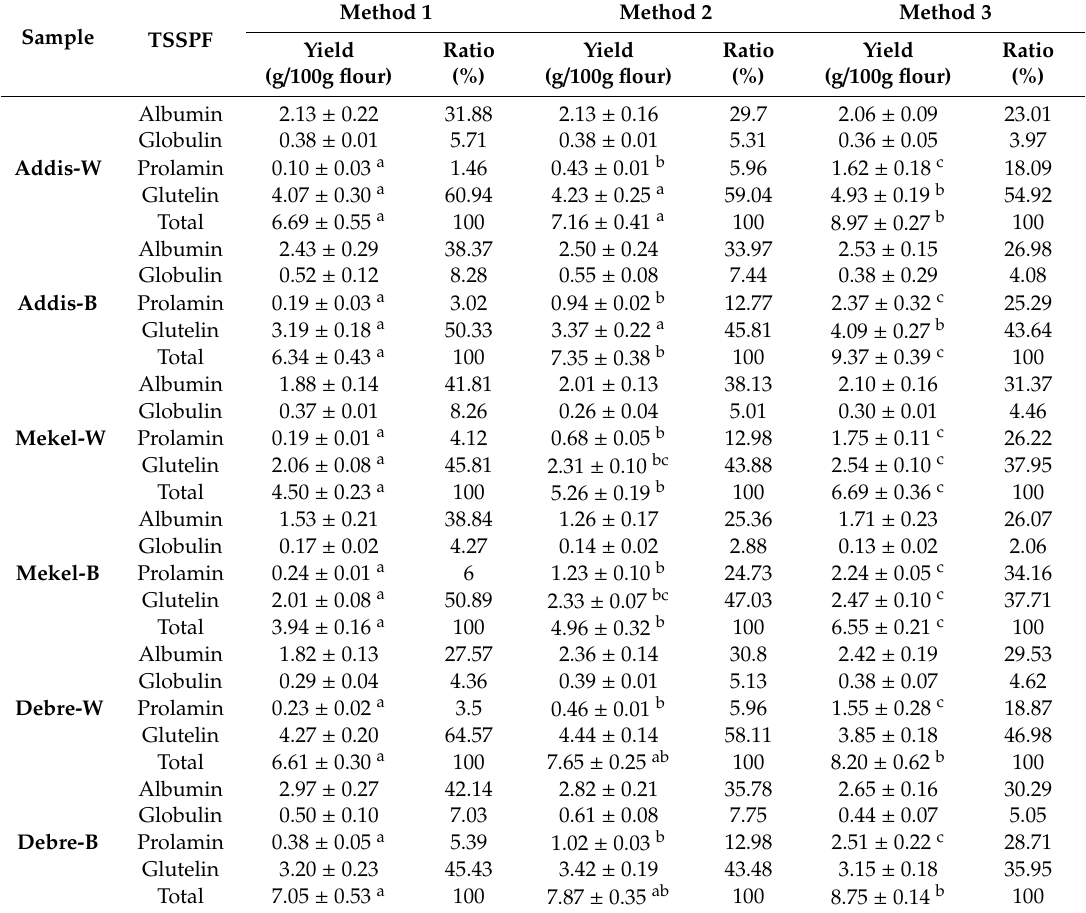
Table 2. E ff ects of di ff erent extraction methods on yield of Te ff seed storage protein fractions